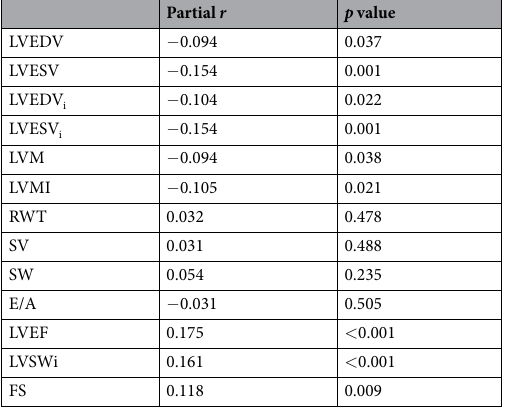
Table 2. Partial correlation coefficients between DPP4 activities and echocardiographic parameters in STEMI patients. After adjustment for age, sex, gamma-glutamyltransferase, creatinine, MB isoenzyme of creatine kinase, pro- brain natriuretic peptide, hypertension, diabetes and hyperlipemia. DPP4a, plasma dipeptidyl peptidase-4 activity; LV, left ventricular; LVEDV, LV end-diastolic volume; LVESV, LV end-systolic volume; LVEDVi, LVEDV index; LVESVi, LVESV index; LVM, LV mass; LVMI, LVM index; RWT, relative wall thickness; SV, stroke volume; SW, stroke work; E, maximum early transmitral velocity in diastole; A, maximum late transmitral velocity in diastole; LVEF, LV ejection fraction; LVSWi, LV stroke work index; FS, subendocardial fractional shortening.